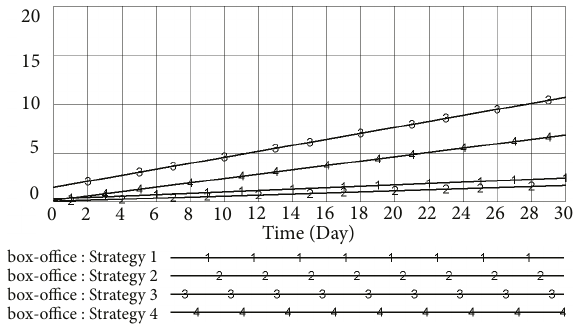
Figure 9: Box-office trend of fans against film release time.